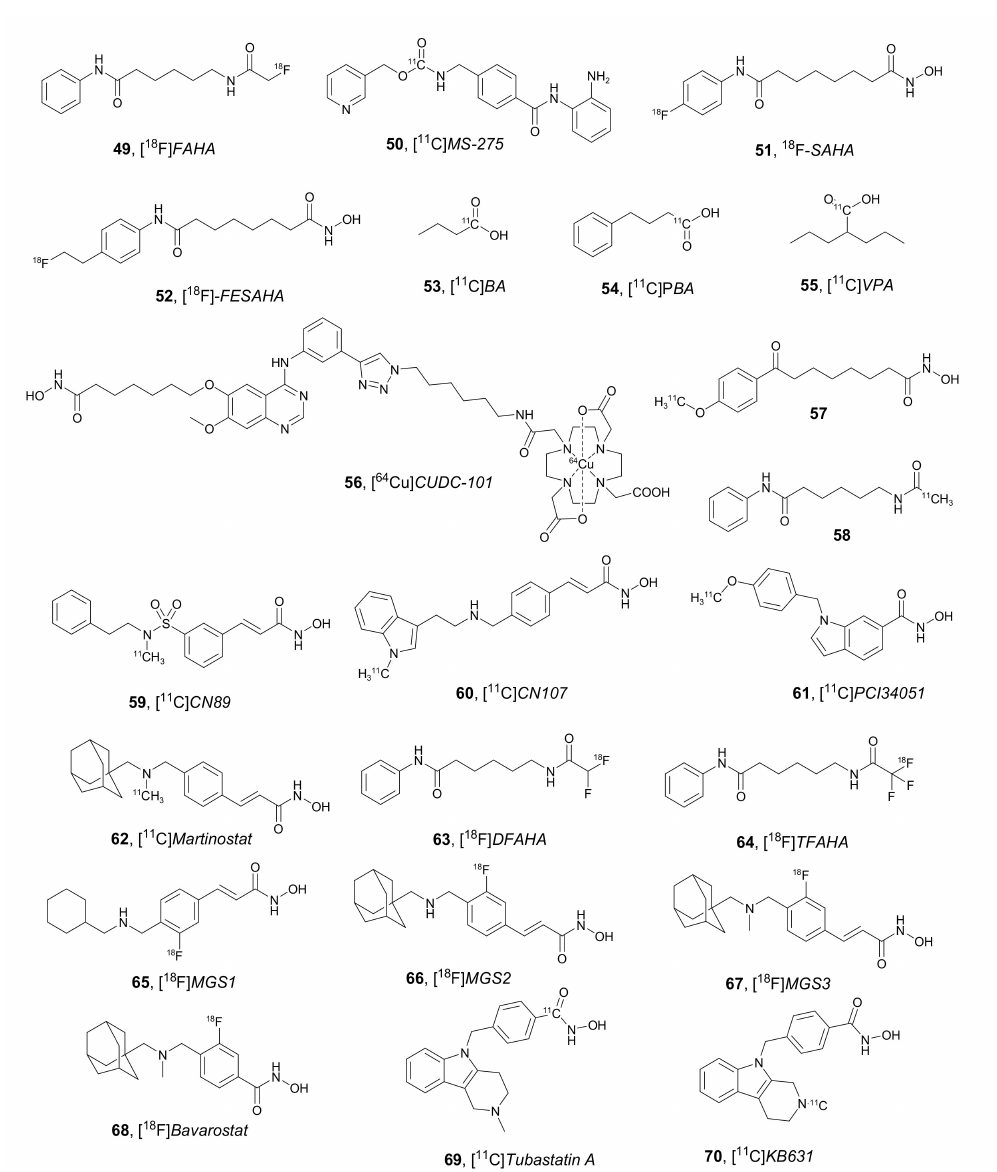
Figure 24. Chemical structures of PET ligands that possess HDAC affinity (compounds 49 – 70